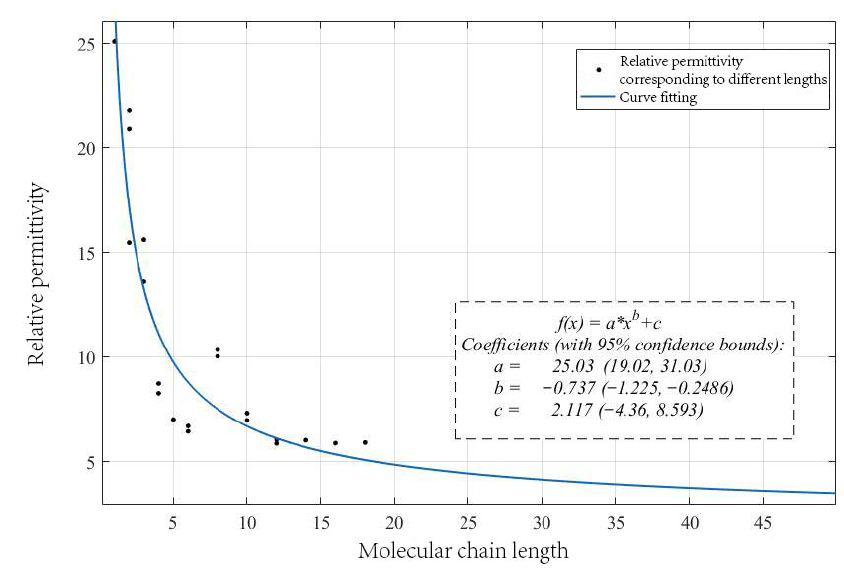
Figure 4. The relationship between the number of molecular chains and 